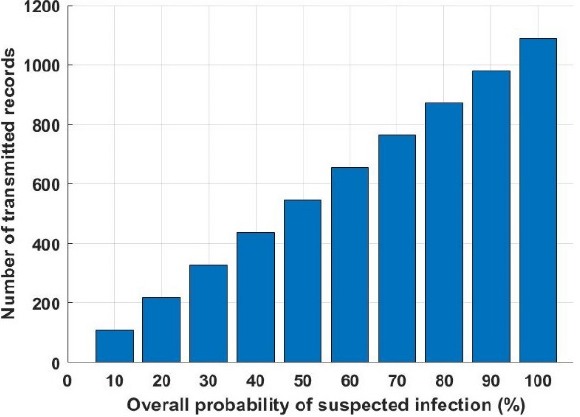
Figure 6. The overall probability of suspected infection versus the number of transmitted records.